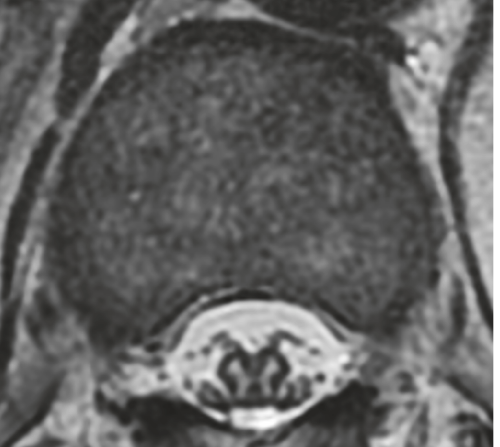
Figure 4: T2-weighted MRI at the T12 level showed bilateral hyperintensities in the anterior horns of the grey matter. MRI, magnetic resonance